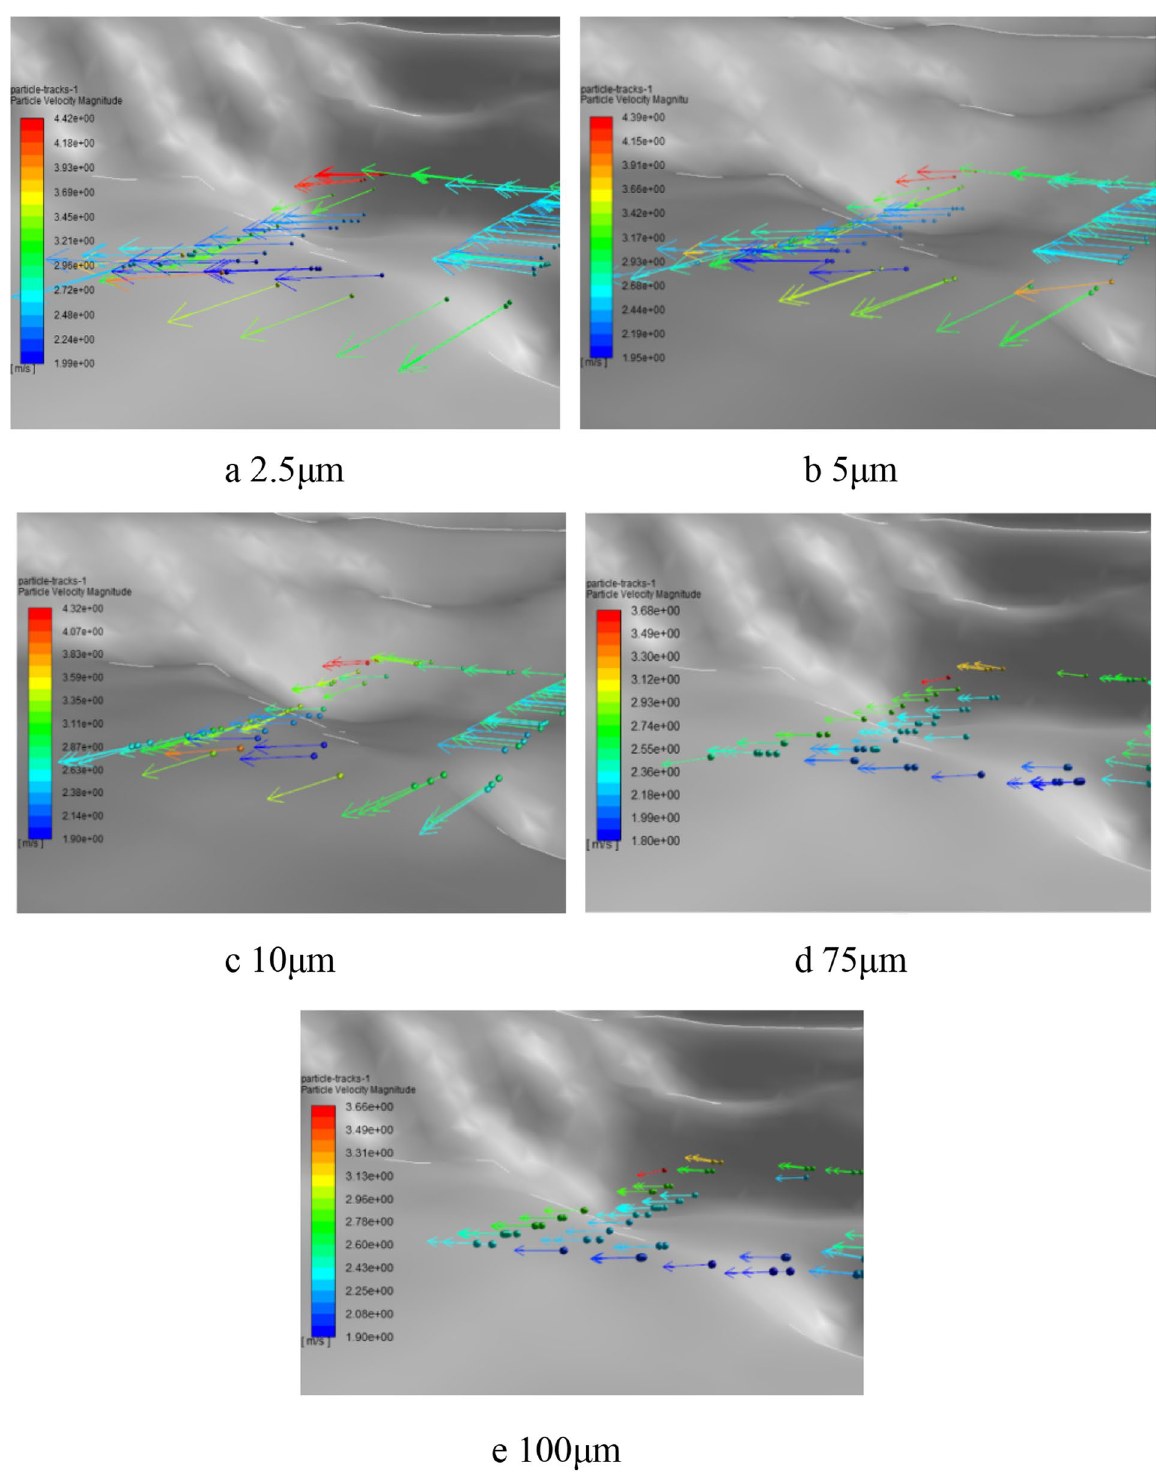
Figure 4. Movement trajectories of dust particles of five particle sizes by Fluent